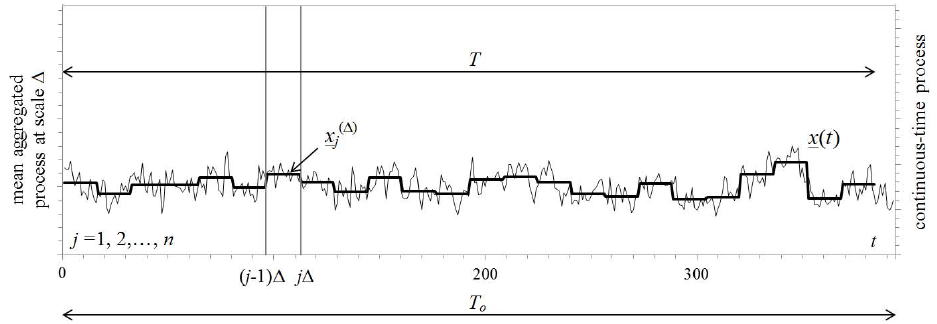
Fig. 1. Sketch of the local average process x (1) obtained by averaging the continuous-time process x ( t) locally over intervals of size 1 j